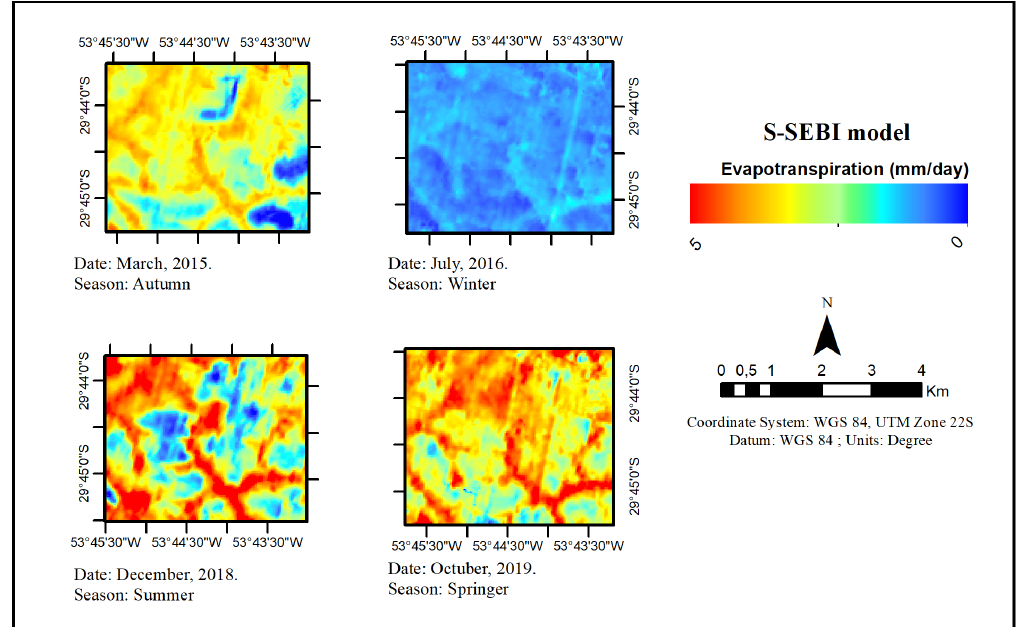
Figure 5. Spatial Daily evapotranspiration (mm/day) for different seasons in Pampa biome.